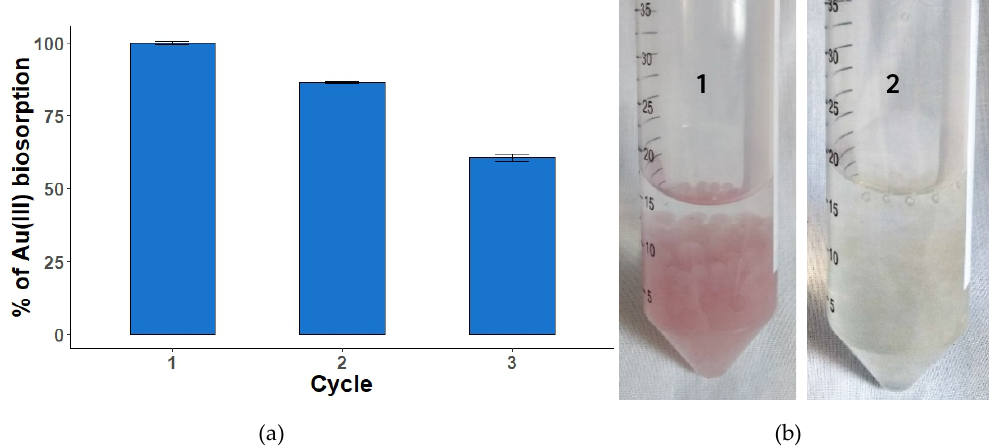
Figure 5. ( a ) Reusability of the encapsulated L. sphaericus CBAM5 cells for 3 cycles of 4 h. ( b ) Bioassays with 1. Encapsulated CBAM5 and 2. Alginate spheres without bacteria, showing the difference of color in the matrix obtained after 3 cycles of reuse.